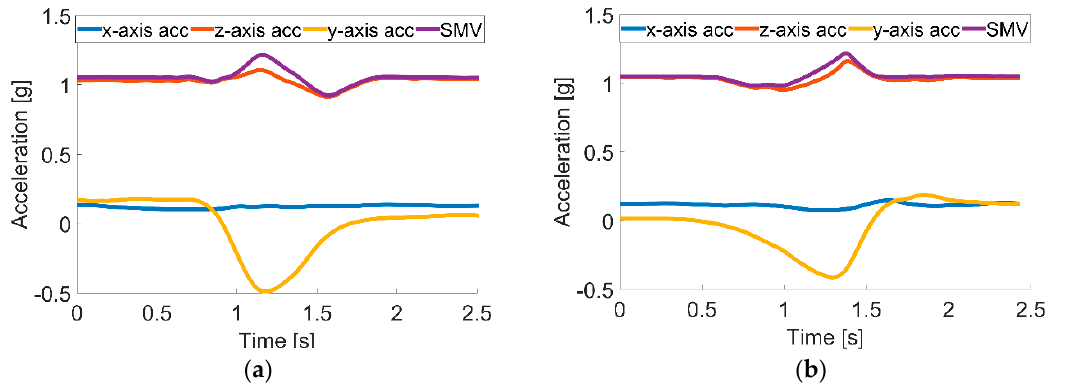
Figure 13. Accelerations in the x -, y - and z -axis and SMV readings during activities: ( a ) getting up and ( b ) sitting down.